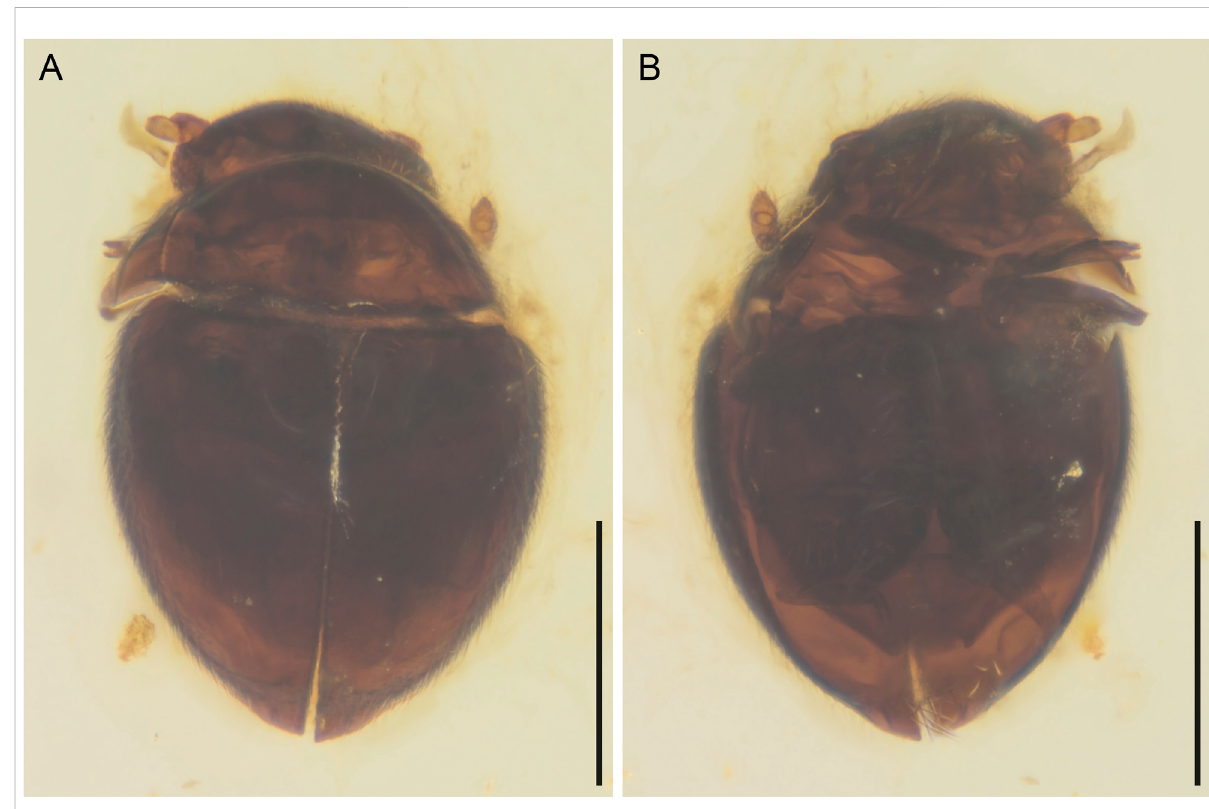
FIGURE 3 Generalhabitusof Crowsonaeriusminutus Li&Caigen.etsp.nov.,holotype,NIGP178178,underincidentlight. (A) Dorsalview. (B) Ventralview. Scale bars: 200 μ